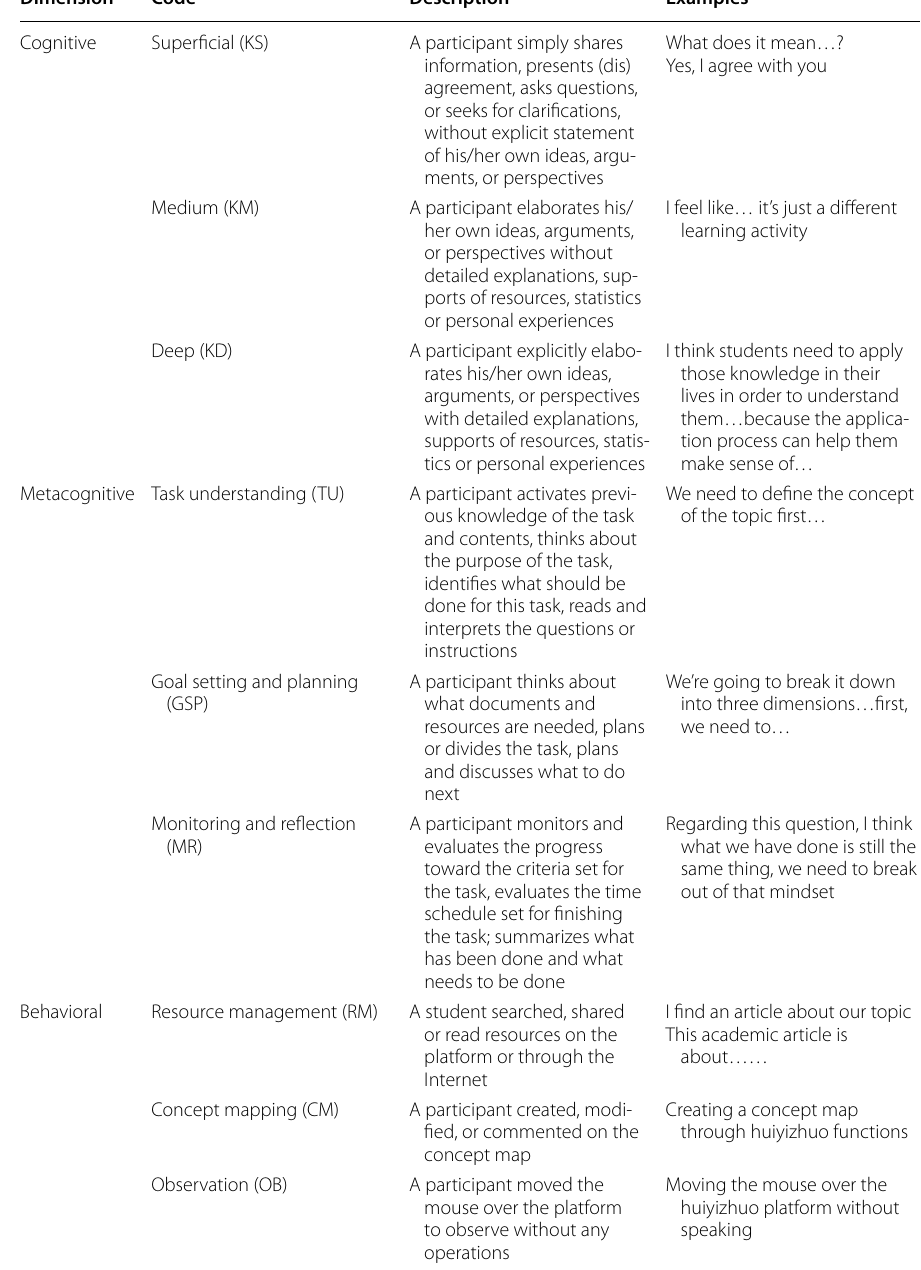
Table 3 The analysis dimensions and descriptions Dimension Code Description Examples